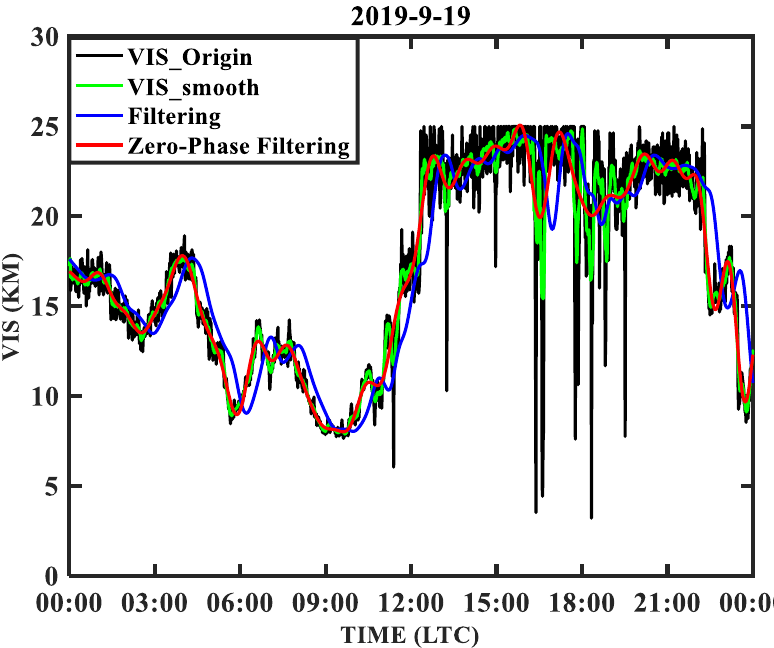
Figure 2. VIS preprocessing results, including: raw data (black line); 10-point moving average (green line); Butterworth low-pass filtering (blue line), and non-delay Butterworth low-pass filtering (red line).